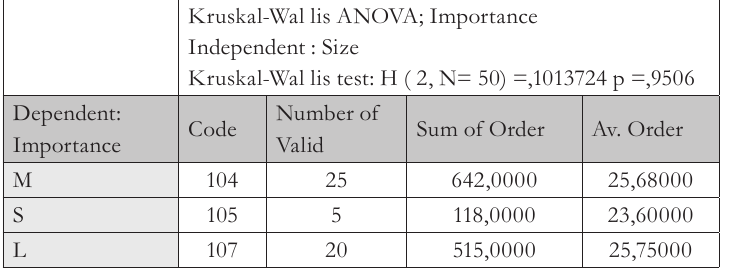
Tab. 7 – Kruskal-Wallis test, Importance and Sector, Source: Own processing at STATISTICA, 2015 Kruskal -Wall is ANOVA: Importance Independent :